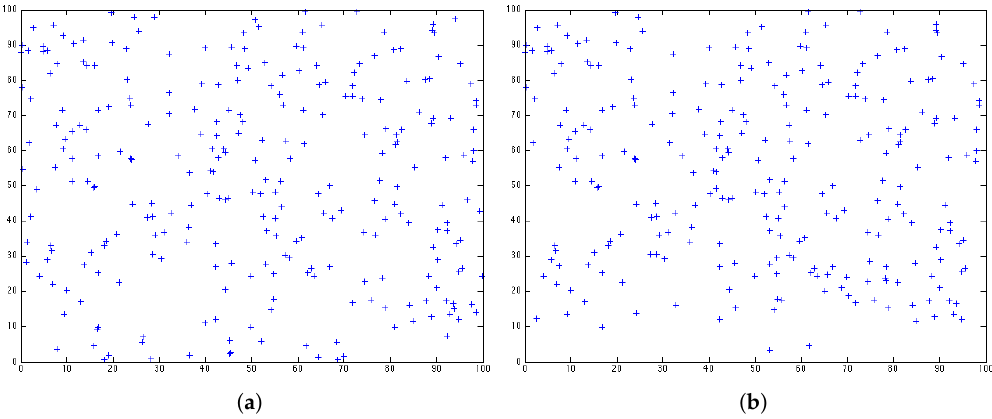
Figure 3. Distribution of nodes still alive after 450 rounds. ( a ) LEACH; ( b ) HEED.